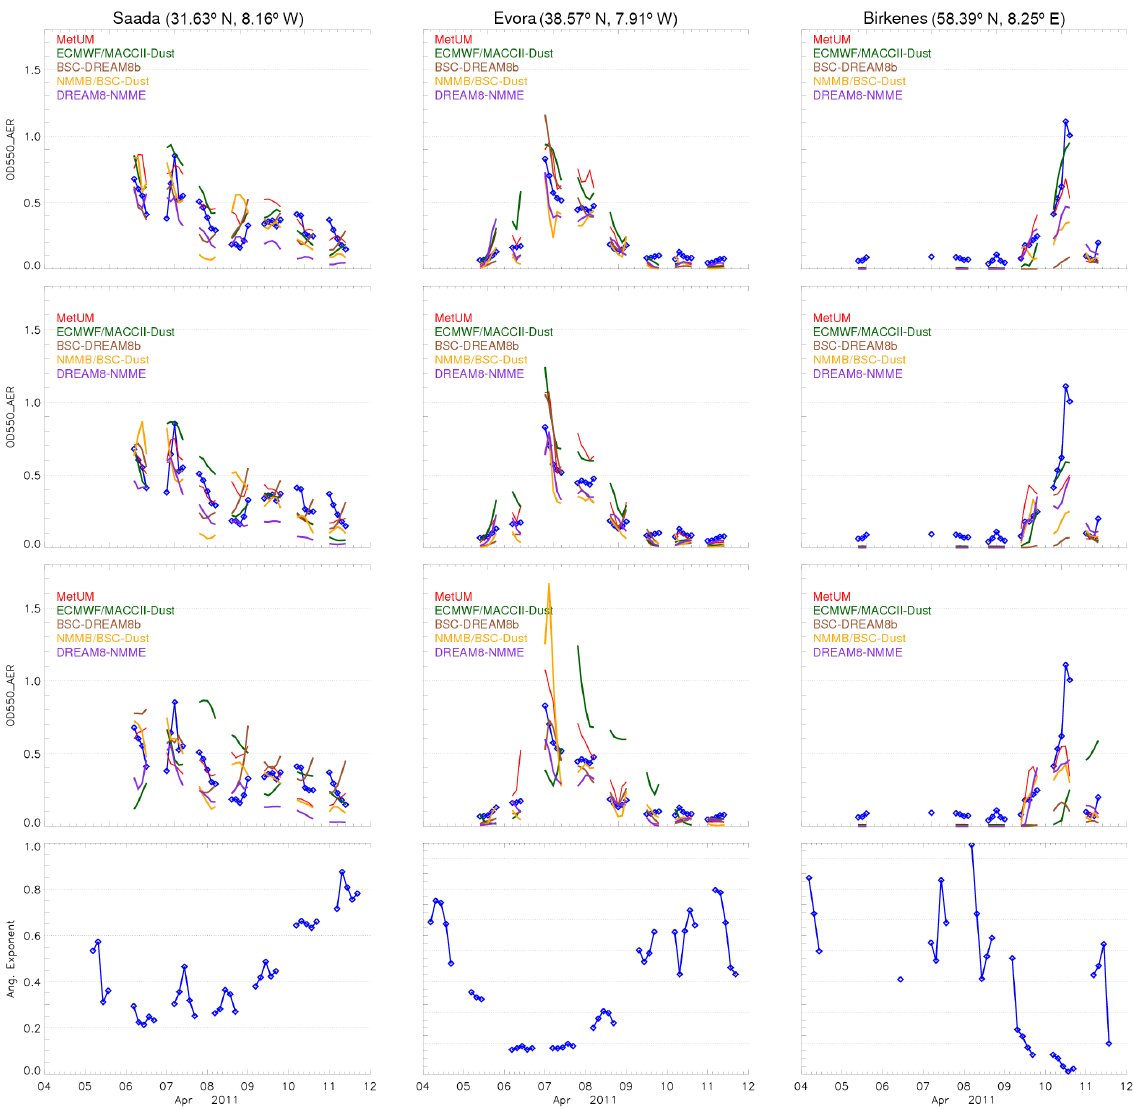
Figure 2. Total AOD at 550nm at three selected sites from the AERONET network (blue line) and 24 (first row), 48 (second row) and 72h (third row) forecasts of the models MetUM (red), ECMWF/MACC (green), BSC-DREAM8b (brown), NMMB/BSC-Dust (orange) and DREAM8-NMME (purple) are illustrated. The Angström exponent (dark blue dots) from the AERONET network at the three selected sites is included in the forth row. Angström exponents<0.75 indicate the dominance of desert